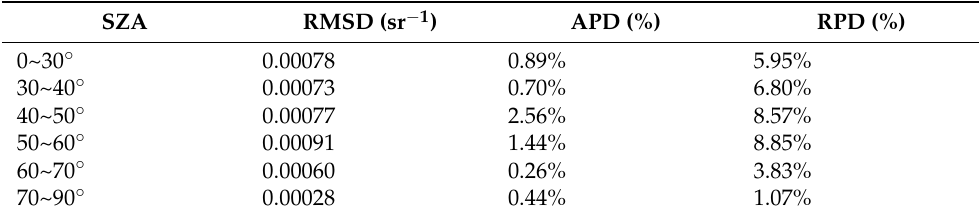
Figure 3. Inversion results of the neural network atmospheric correction algorithm in each HY-1C- COCTS band. The color bar represents the number of points. Table 2. The statistical parameters obtained by the algorithm are verified using precision evaluation datasets for different bands.